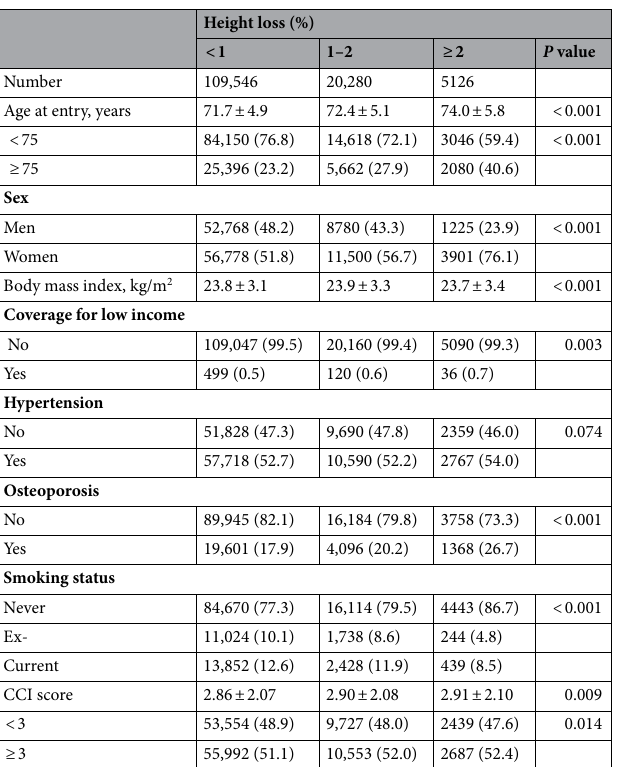
Table 1. Baseline characteristics of study participants by degree of height loss. CCI Charlson Comorbidity Index. Data are presented as mean ± standard deviation or number